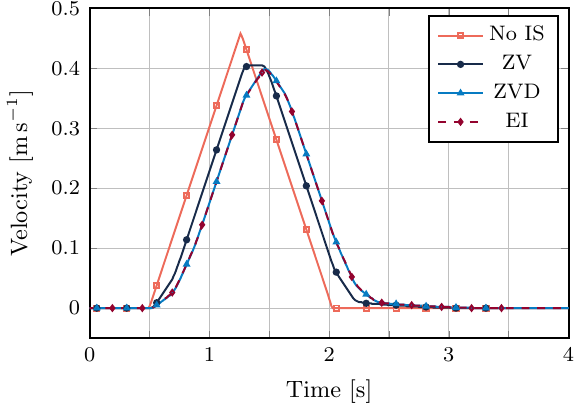
Figure 3: Comparison of driven velocity profiles v ( t ) for the various